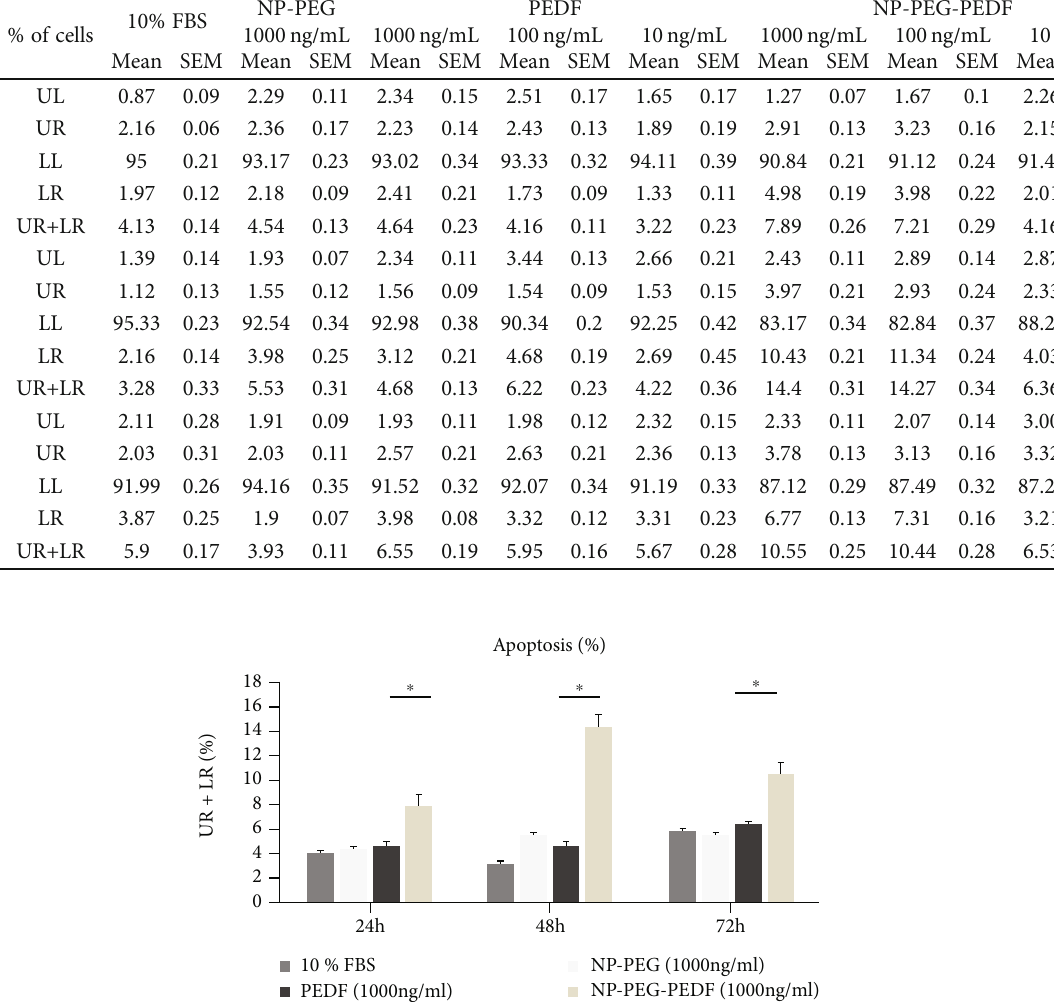
Table 3: Summary of fl ow cytometry data of apoptosis measured by annexin V and PI. Time point % of cells